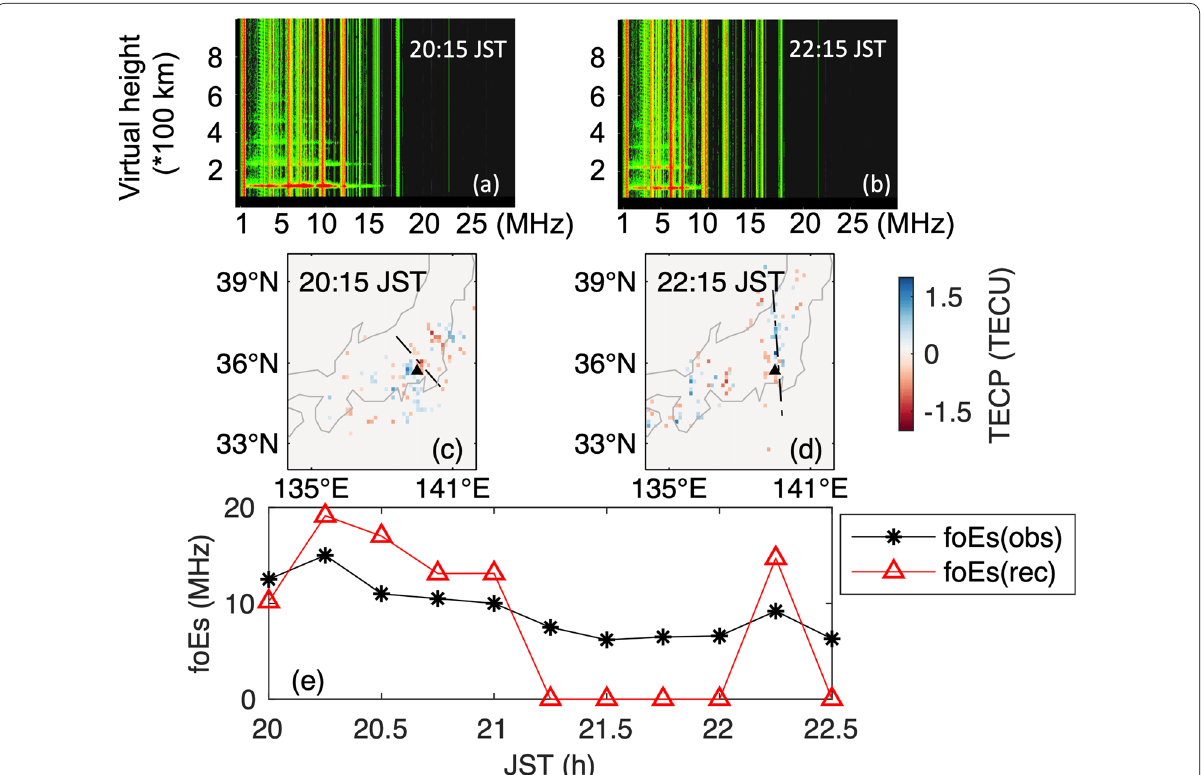
Fig. 7 Ionogram observed by Kokubunji ionosonde ( a , b ), and snapshots of TECP maps at E shell height ( c , d ) at 20:15 and 22:15 JST on 23 June 2012 (DOY 175). Black triangle represents the location of Kokubunji ionosonde. ( e) The variation of the foEs obtained from ionosonde observations ( foEs ( obs ) ) and reconstructed TECPs ( foEs ( rec ) ; a 2 km thickness is assumed) at Kokubunji area during 20:00–22:30